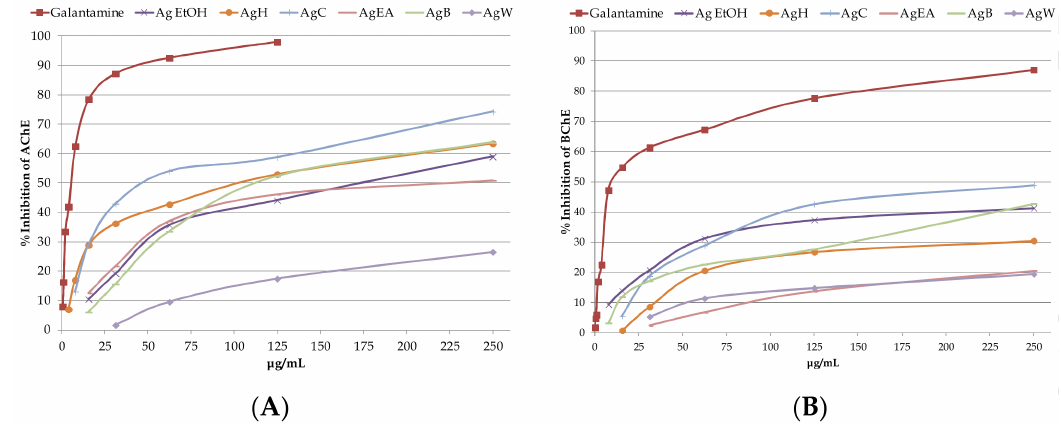
Figure 2. Acetylcholinesterase (AChE) ( A ) and butyrylcholinesterase (BChE) ( B ) inhibition activity of galantamine and Azorella glabra samples. Samples are galantamine, crude ethanol extract (Ag EtOH), n -hexane fraction (AgH), chloroform fraction (AgC), ethyl acetate fraction (AgEA), n -butanol fraction (AgB), and water fraction (AgW). Data are mean ± standard deviation from three experiments performed in